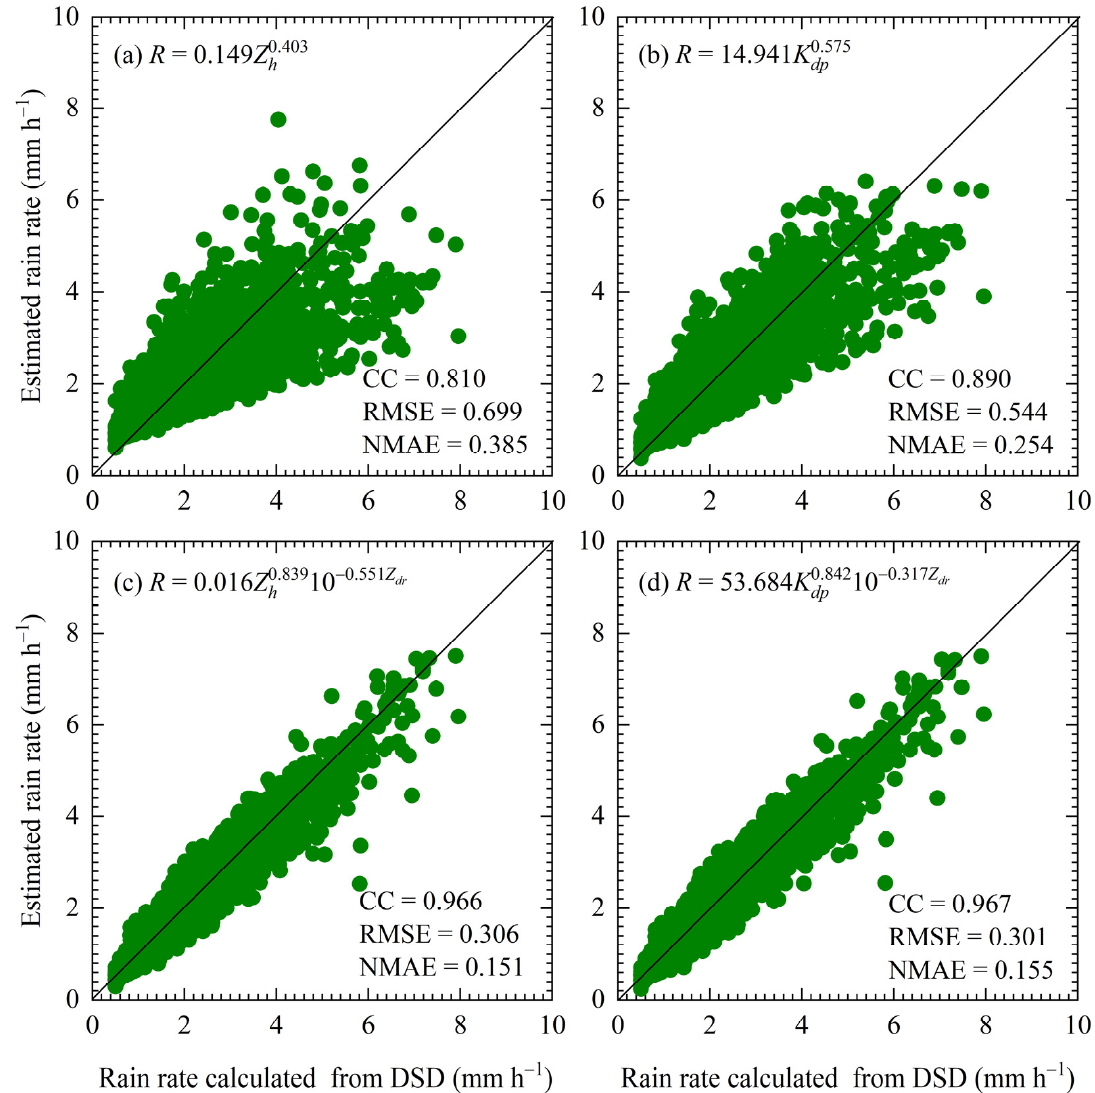
Figure 9. Scatterplot of estimated rain rate from ( a ) R ( Z h ), ( b ) R ( K dp ), ( c ) R ( Z h , Z dr ), and ( d ) R ( K dp , Z dr ) relations versus the rain rate calculated from DSD for stratiform rainfall in Zhaosu. The solid black line represents the 1:1 relation.